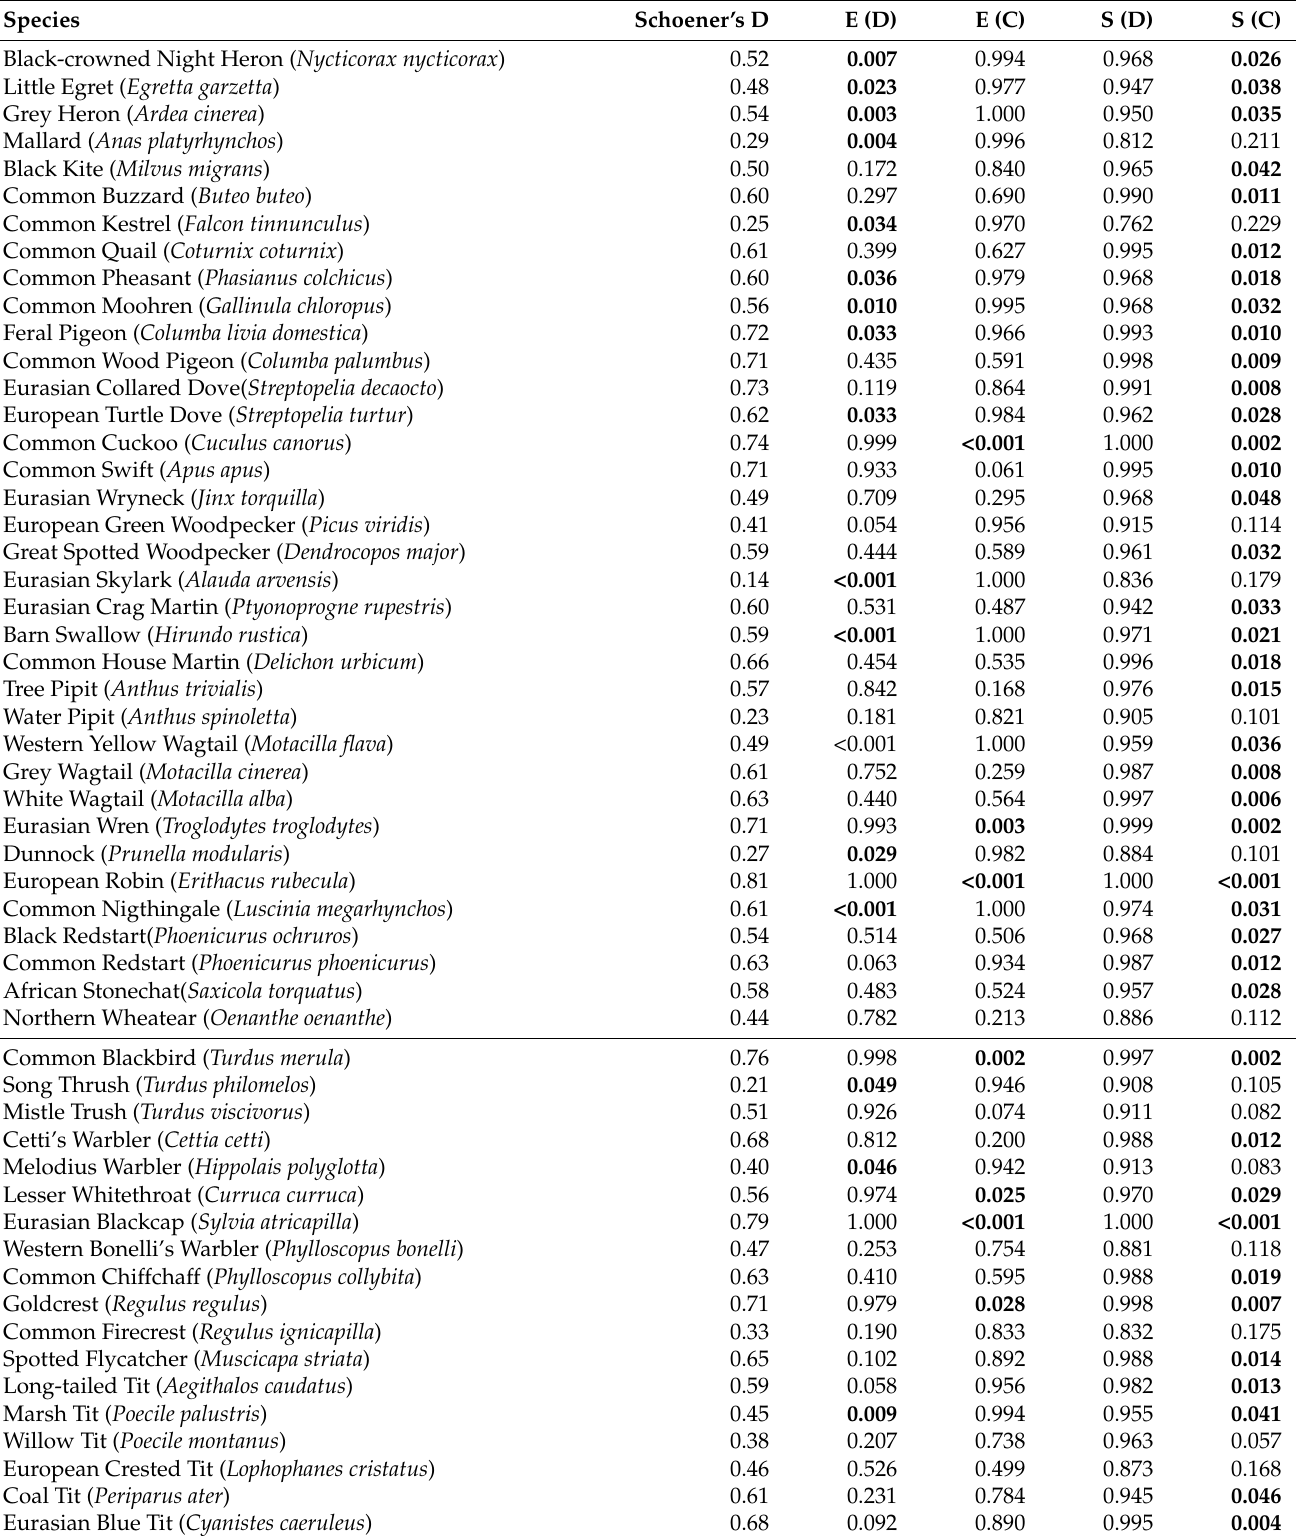
Table 1. Schoener’s D index and p -values for the equivalency (E) and similarity (S) test for